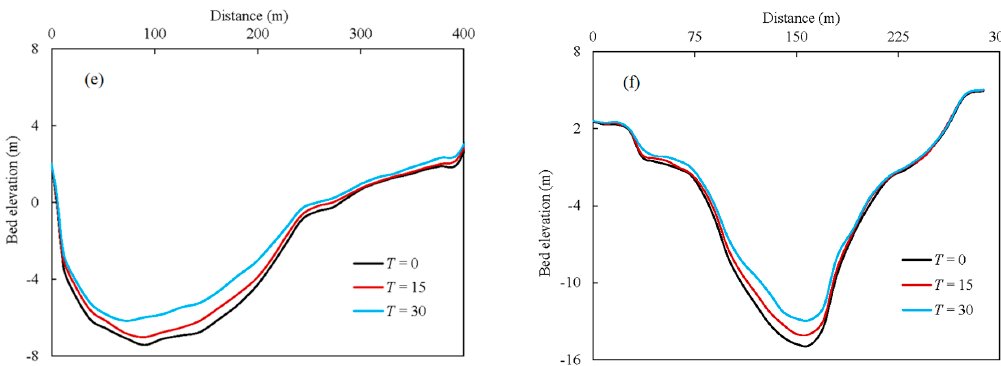
Figure 14. Morphological changes during the spring tide: ( a ) T = 0 (measured bed level); ( b ) T = 15 days; ( c ) T = 30 days; cross-sectional bed level changes at ( d ) WL4; ( e ) FS4; ( f ) WL5.